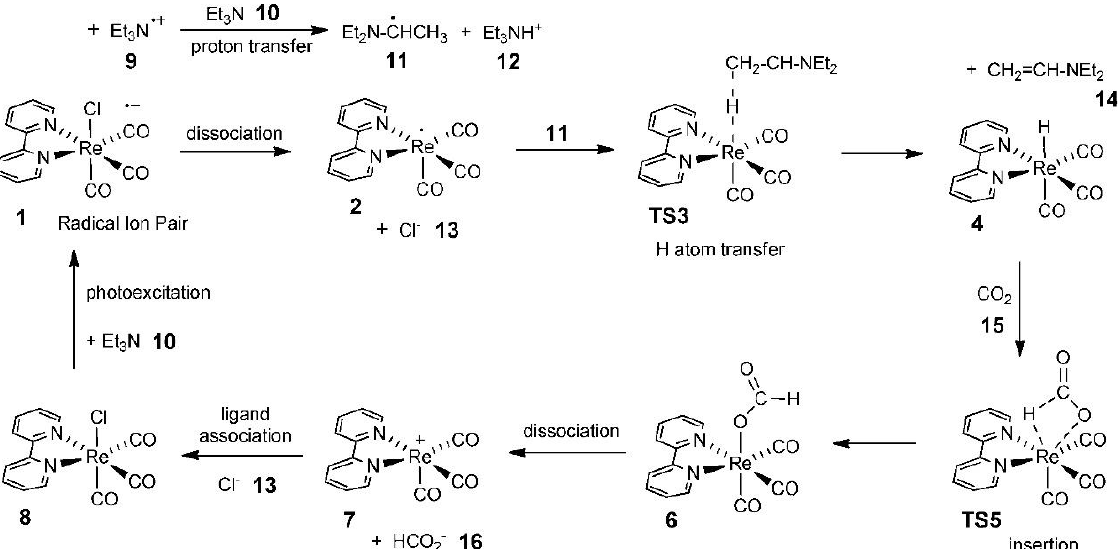
Figure 13. Computed photocatalytic cycle for CO 2 reduction on a Re catalyst. Reprinted from Ref. [128], copyright (2011), with permission from the American Chemical Society.